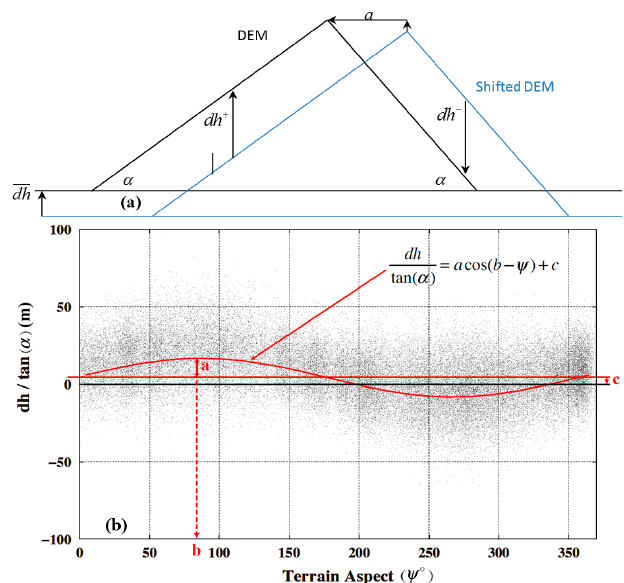
Figure 2. Elevation differences due to different coordinate frames (registration-induced errors). ( a ) A 2D scheme of elevation differences induced by a coordinate shift; ( b ) elevation differences following the relationship in Equation (1) between the vertical deviations normalized by the slope tangent (y-axis) and the terrain aspect (x-axis). (The method is from Nuth and Kääb [33]). (2) Elevation-dependent correction